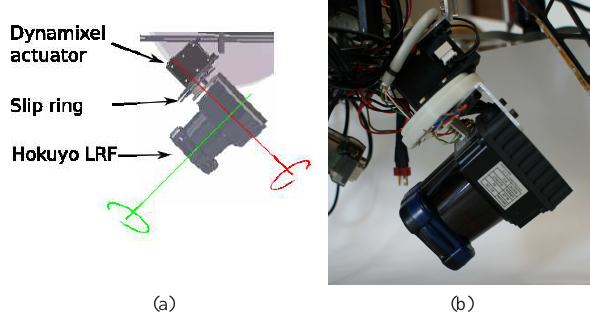
Figure 2: (a) CAD drawing of the continuously rotating laser scanner with the two rotation axes. The Hokuyo 2D LRF is mounted on a bearing and rotated around the red axis. (b) A photo of the assembled laser scanner.